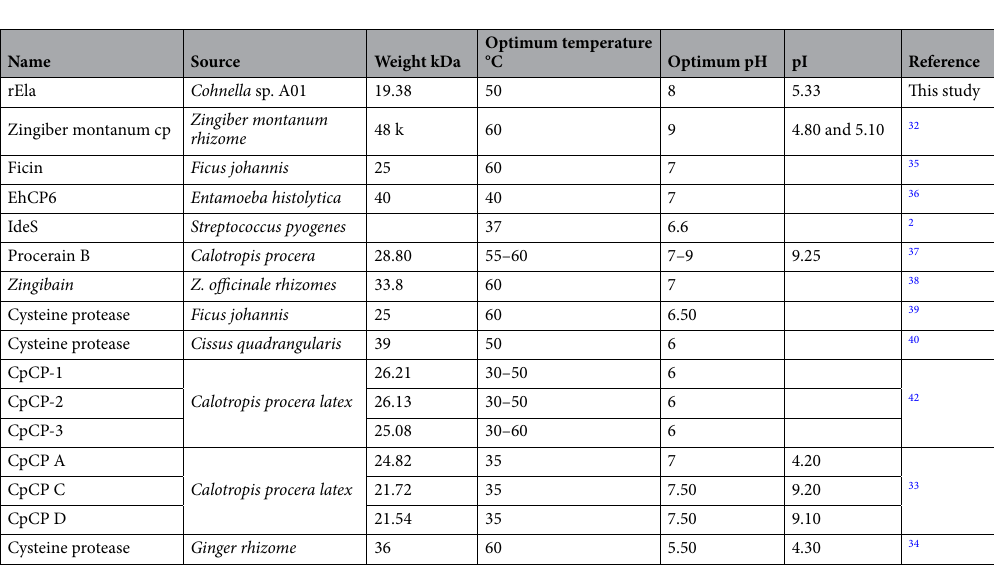
Table 2. Molecular weight, optimum temperature, pH and pI of some of the well-studied cysteine